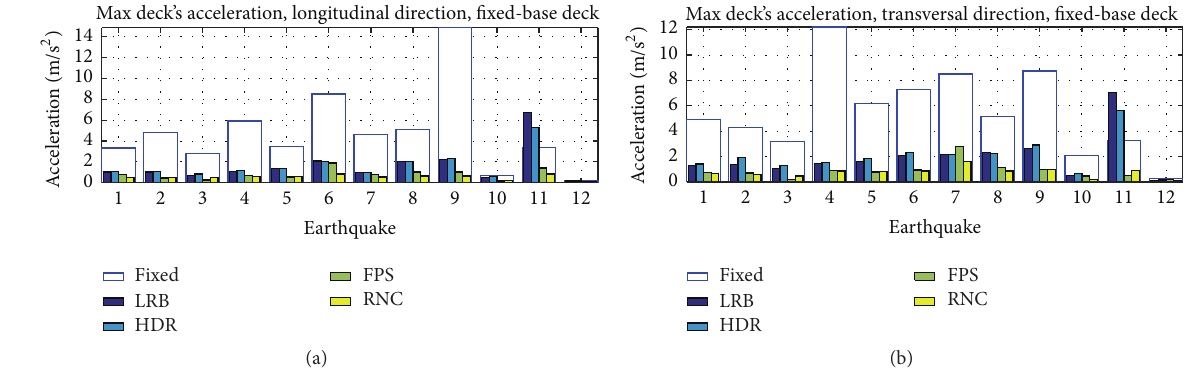
Max deck’s acceleration, longitudinal direction, fixed-base deck